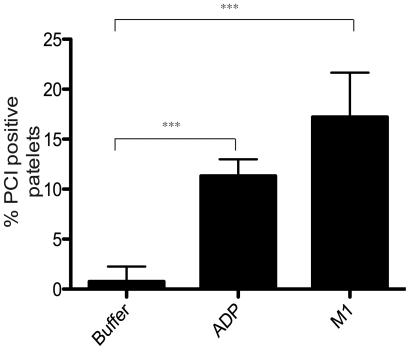
PCI associated with platelets.Platelet rich plasma was incubated with buffer, ADP (5 µM), or M1 protein (1 µg/ml). After 5 minutes, PCI was detected on the platelet surface using flow cytometry. The percentage of the platelet population that presented PCI on their surface was determined using Cell Quest Software (BD Biosciences). ADP and M1 protein stimulated PCI associated to platelets. Statistical significance was determined using students T test. ***  = P<0.001. Values are means, vertical lines show SEM; n = 4.